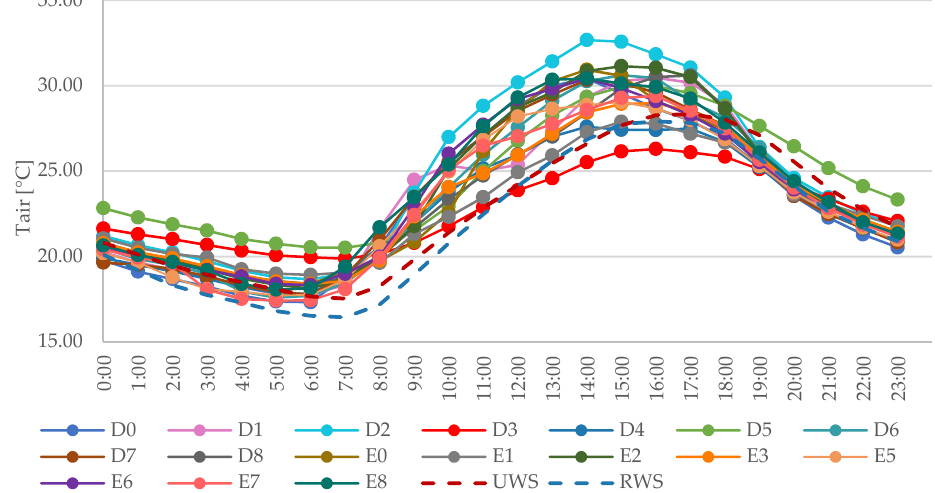
* Although the sensors have an accuracy of ±0.5 °C on T air and ±4.0% on RH, we report the values with 4 significant digits as given during the sensor read-out.